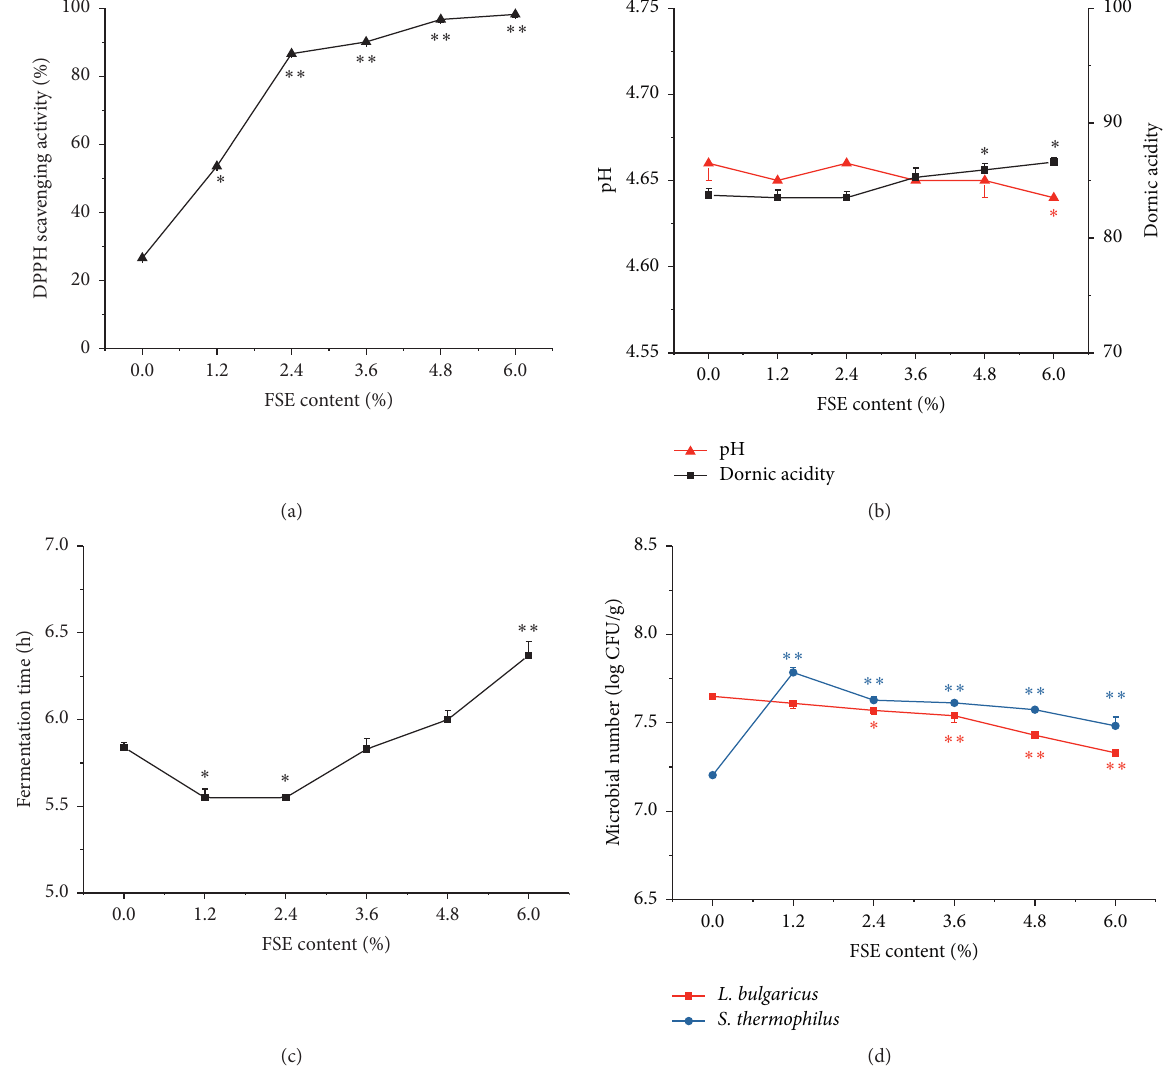
Figure 1: Effect of supplementing different concentrations of FSE on the antioxidant activity, physicochemical profiles, and microbial counts of yogurts: (a) DPPH scavenging capacity; (b) pH and Dornic acidity; (c) fermentation time; (d) quantities of L. bulgaricus and S. thermophilus. ∗ Significant difference at p < 0 . 05; ∗∗ significant difference at p < 0 . 01 compared with Con. FSE: Flos Sophorae extract; Con: the yogurt without FSE or